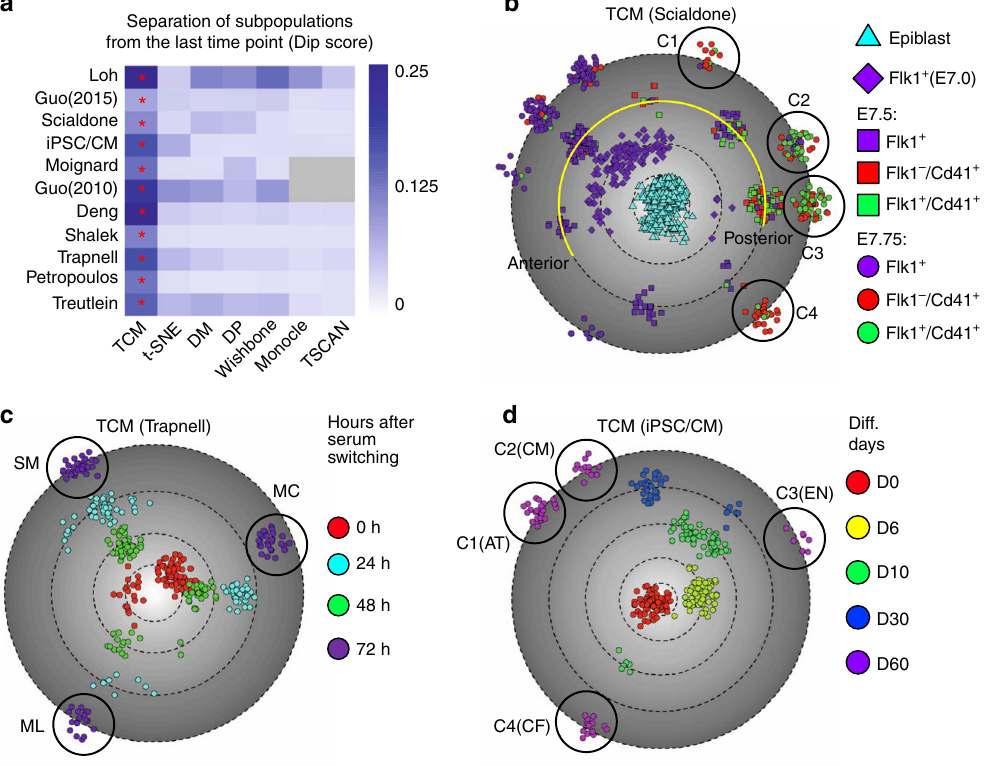
Fig. 4 TCM identi fi es subpopulations of cells from the last time points for the visualizing of temporal single cell expression data. a The heatmap indicates the capability of separating subpopulations from the last time point on the two dimensional latent space produced by TCM, t-SNE, diffusion map (DM), diffusion pseudotime (DP), Wishbone, Monocle, and TSCAN on 11 examined single cell expression datasets. The performance is quantitatively measured by Hartigan ’ s Dip statistics using the cells ’ coordinates on the latent space. The high Dip score suggests the cells from the last time point are separated to a greater extent on the latent space. The red asterisk indicates the method that provides the highest Dip score. b TCM is used to visualize the scRNA-seq dataset of mouse mesodermal diversi fi cation. The principal anterior-posterior axis is highlighted along the single cells captured at E7.5. TCM identi fi es four hematopoietic (Cd41 + , red circle Flk1 − /Cd41 + , and green circle Flk1 + /Cd41 + ) subpopulations from E7.75 cells (C1-C4). c TCM is used to visualize the single cell RNA-seq data following the differentiation of human primary myoblasts, where the expression pattern of 372 single cells were pro fi led from 0, 24, 48, and 72 h post-serum switching, respectively. TCM successfully identi fi es three distinct subpopulations: skeletal muscle (SM), interstitial mesenchymal cells (MC) and myocyte-like cells (ML) from the last time point (72 h). d TCM is used to visualize the scRNA-seq dataset of human